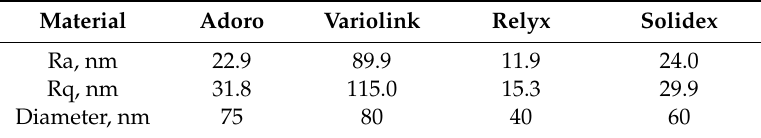
Table 2. Values measured with AFM for the initial